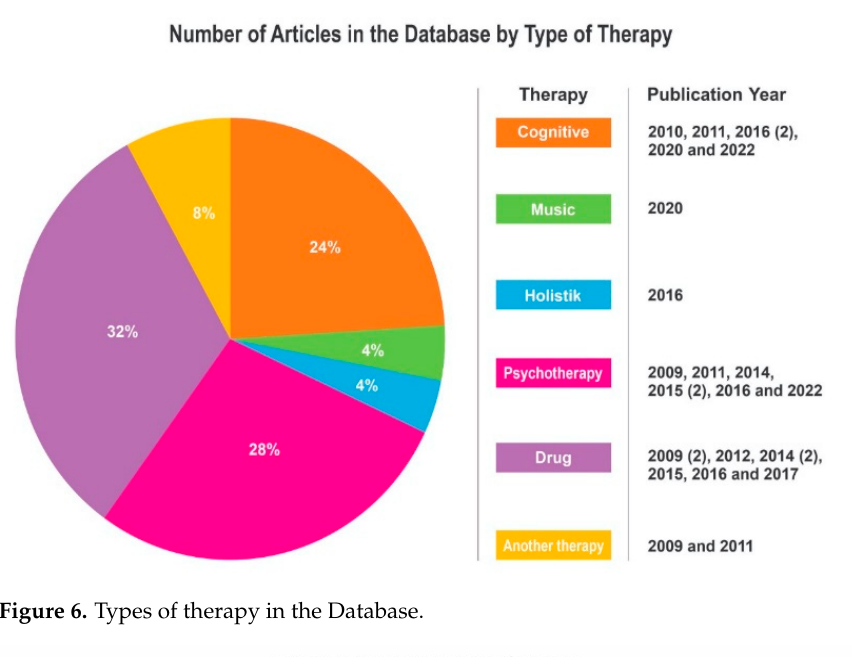
Figure 6. Types of therapy in the Database.